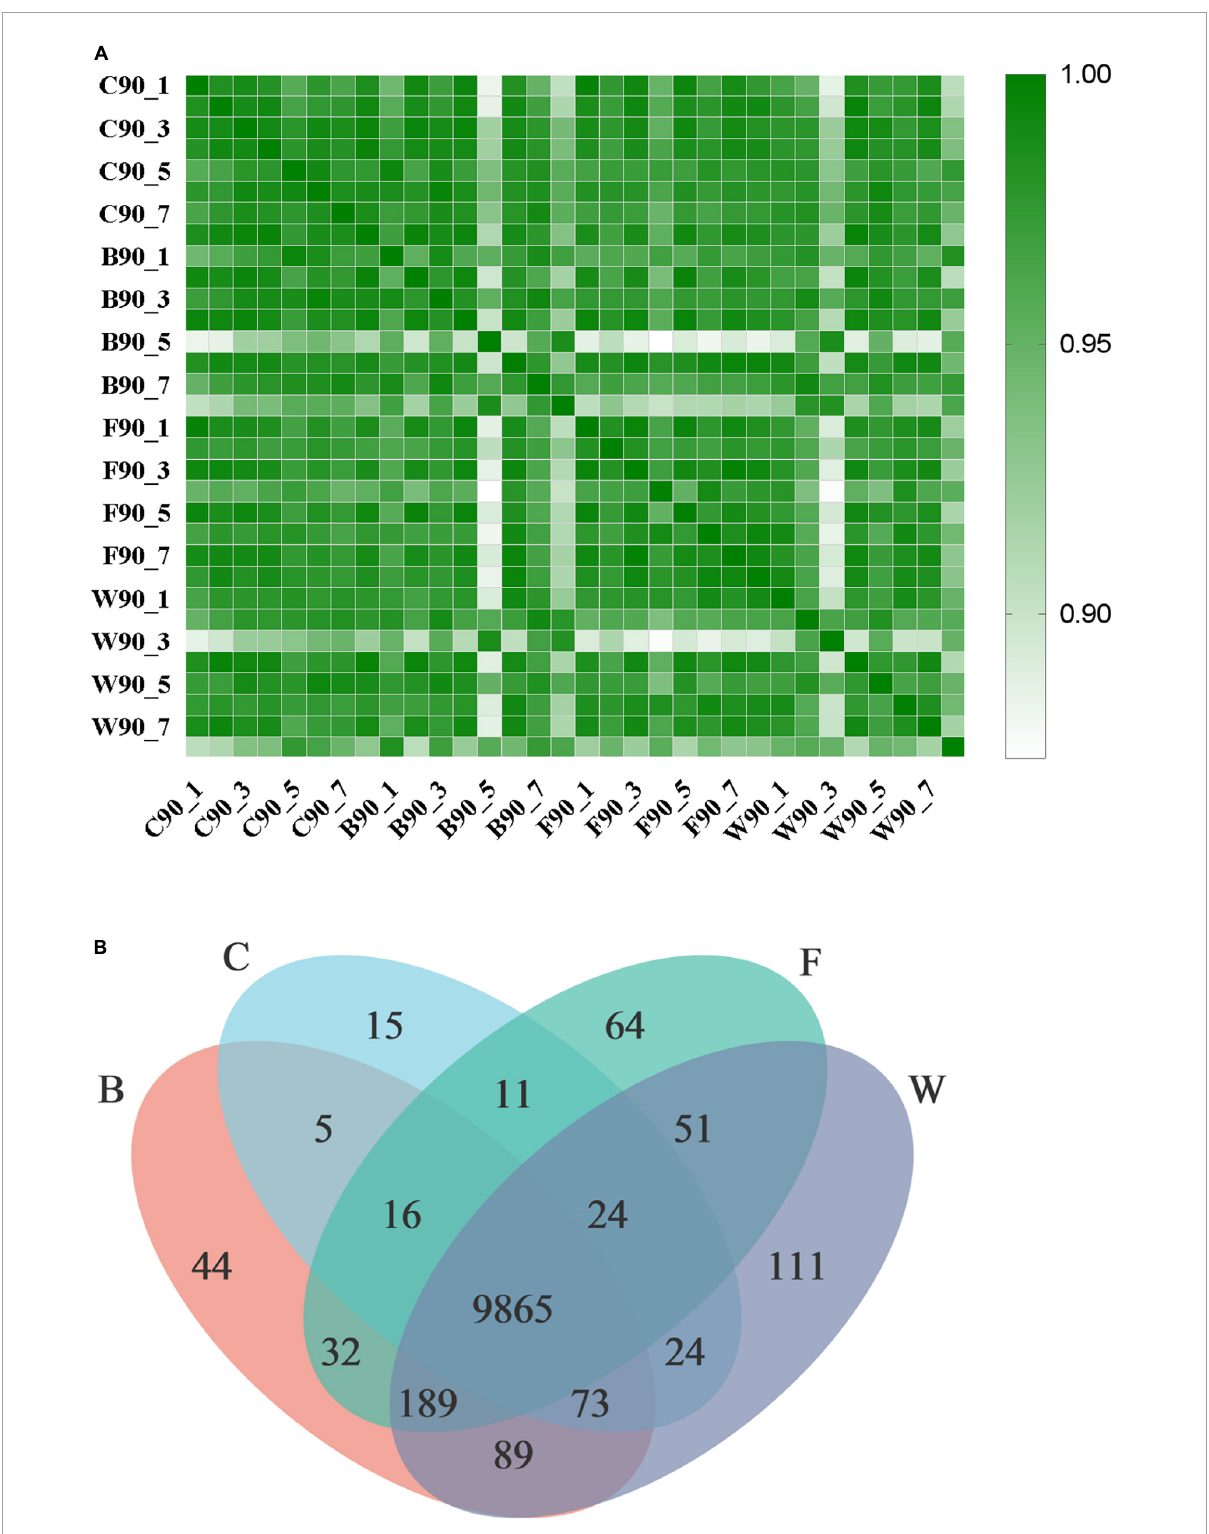
FIGURE4 Transcriptomic profiles of liver tissues in four groups of Landes geese (i.e., groups C, B, F, and W) on day 90. (A) The Pearson correlation coefficient ( R 2 ) heat map among individual samples in four groups of Landes geese ( P < 0.01). (B) Venn diagram showing the number of expressed genes detected in four groups of Landes geese. Group C, control group; Group B, added with 4% BSG in the overfeeding stage (days 61–90); Group F, added with 4% BSG in the rearing stage (days 5–60); Group W, added with 4% BSG in the all stage (days